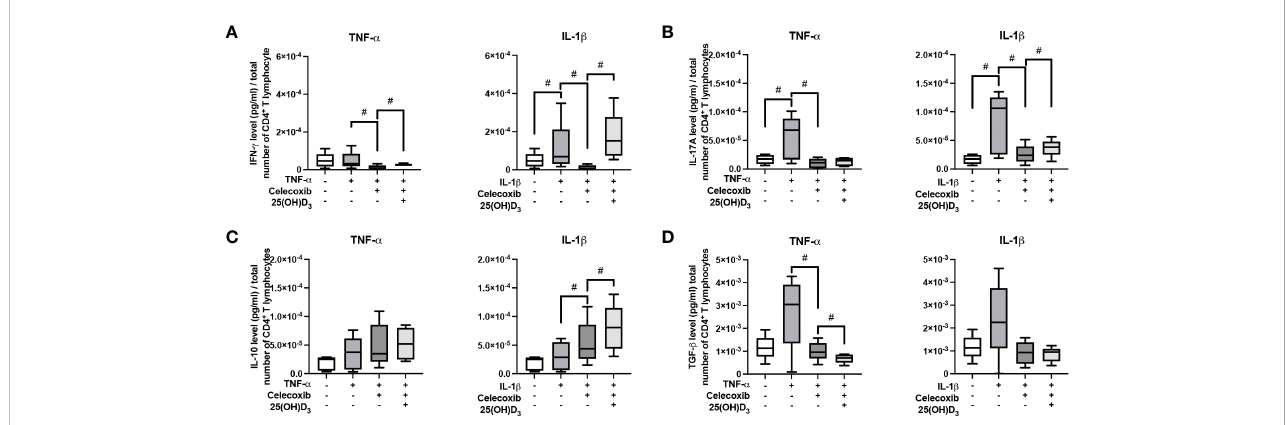
FIGURE 9 In fl uence of PTGS-2 pharmacological inhibition on the production of IFN- g , IL-17A, IL-10, and TGF- b in CD4 + T lymphocytes in the presence of hPDL- MSCs under different cytokine conditions. After fi ve days of indirect co-culture with hPDL-MSCs, the concentrations of IFN- g (A) , IL-17A (B) , IL-10 (C) , and TGF- b (D) were measured in conditioned media using appropriate ELISA and the total CD4 + T lymphocyte numbers per sample were determined using a cell counting chamber. Measured cytokine levels (pg/ml) were normalized to the total CD4 + T lymphocyte number per group. Data were obtained from fi ve (A – D) experimental repetitions using hPDL-MSCs from a different individual per repetition. One technical replicate was used per experimental group. The normalized cytokine levels were presented as a box-whisker plot showing the minimum and maximum values (A – D) . The Friedman test, followed by the Wilcoxon test, was used for pairwise comparison. # p-value < 0.05 were considered to be statistically signi fi cant between groups as